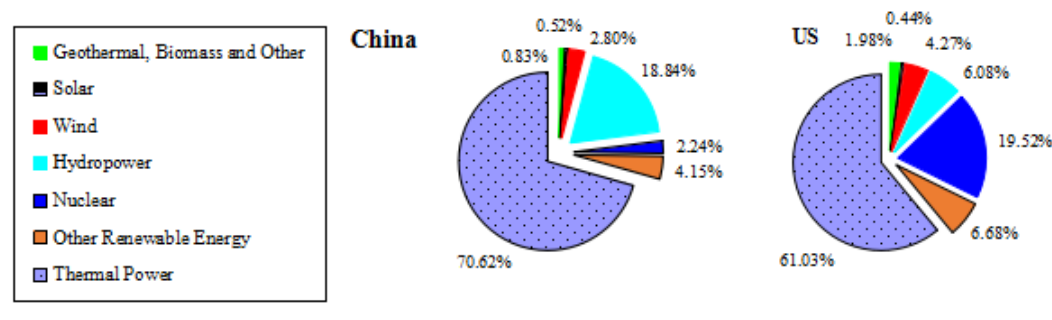
Figure 7. Comparison of renewable energy consumption in 2014 between China and the US.